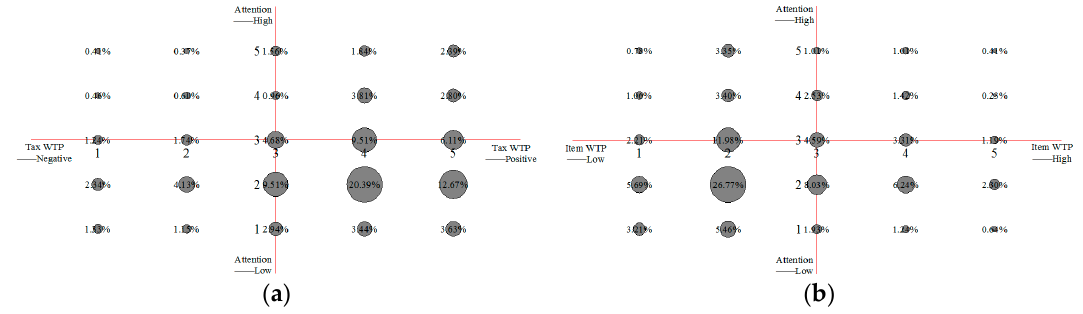
Figure 6. Analysis of attention and WTP to public occupational safety and health connotation. ( a ) Cross analysis of connotation attention and tax WTP; ( b ) Cross analysis of connotation attention and item WTP.